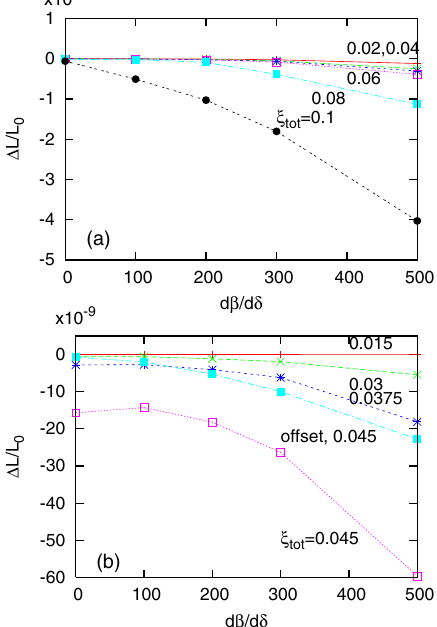
FIG. 16. Luminosity decrement as a function of chromatic beta aberration at IP without (a) and with crossing angle (b). The cyan line in (b) refers to a transverse offset of 0 . 2 σ and total tune shift ξ 0 . 045 tot ¼